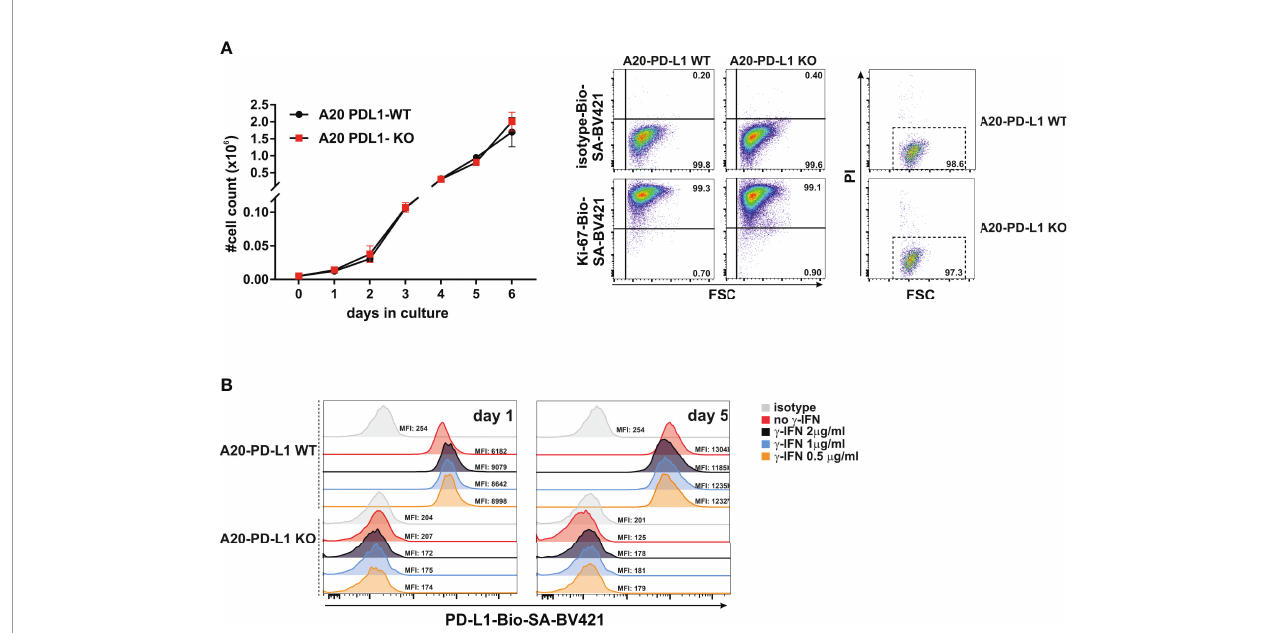
FIGURE 2 | Similar in-vitro proliferation rate of A20 PD-L1 WT and PD-L1 KO leukemia cells and in-vitro upregulation of PD-L1 expression in response to IFN- g . (A) Left panel: Four replicates of A20 PD-L1 WT or PD-L1-de fi cient tumor cells were seeded in a 24-well plate at the rate of 5,000 cells per well, and cell counting was performed every day over a period of 6 days. The total number of cells (×10 6 ) in culture is plotted at different time points. Middle panel: A representative experiment of two showing intracellular Ki-67 staining was used to measure the in-vitro fraction of dividing cells (Ki-67 positive) versus non-dividing cells (Ki-67 negative) in WT and PD-L1-de fi cient cell lines 1 day after seeding them at 3 × 10 5 cells/ml. Right panel: A representative experiment of three illustrating cell death in cell culture measured at the exponential phase of cell growth by staining with propidium iodide. (B) A20 PD-L1 WT or PD-L1-de fi cient leukemia cells were left untreated or incubated for 24 h and 5 days with different concentrations of IFN- g ranging from 0.5 to 2 m g/ml, and PD-L1 expression was monitored by fl ow cytometry. One experiment out of two with similar results. The mean fl uorescence intensity (MFI) is indicated for each